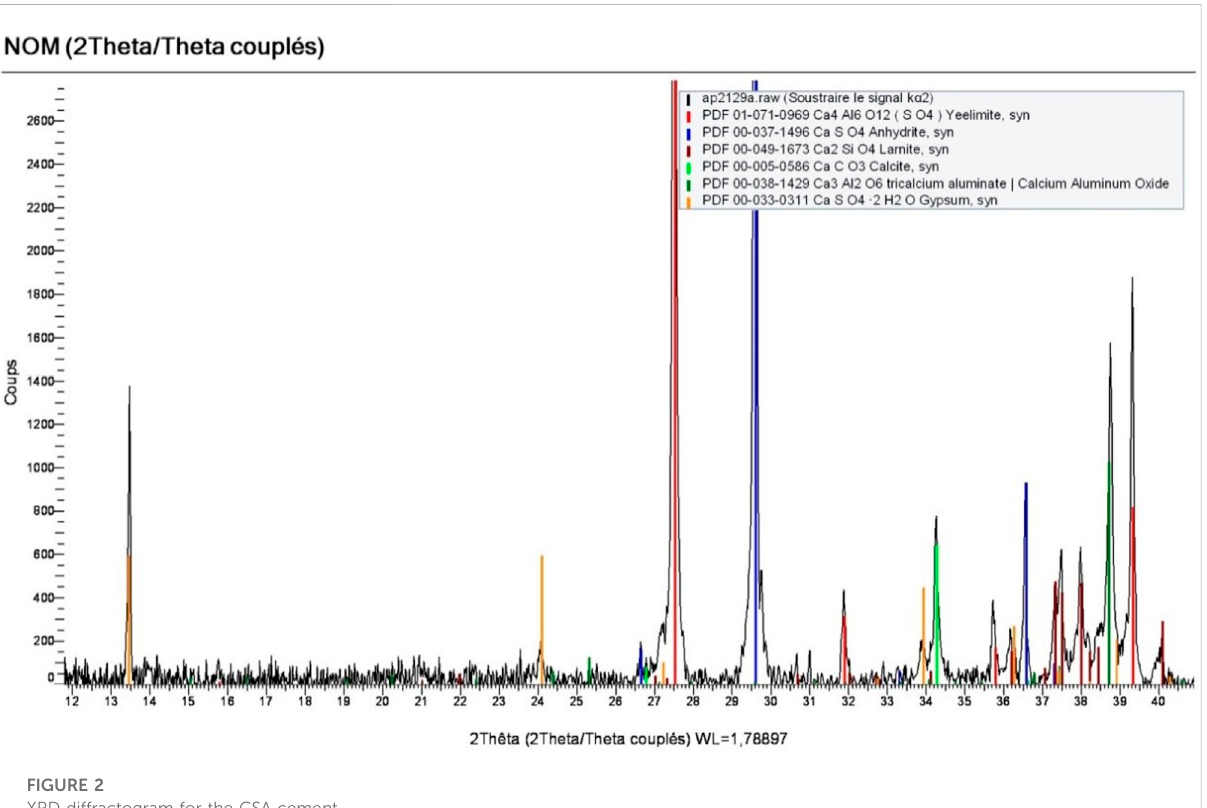
FIGURE 2 XRD diffractogram for the CSA